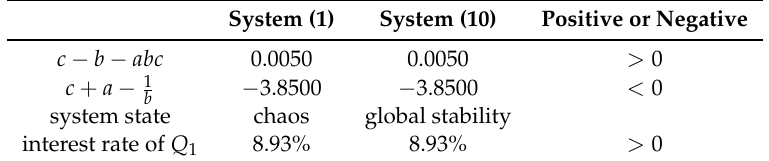
Table 1. Comparisons of System (1) and System (14) under the same data a = 0.9, b = 0.2, c =